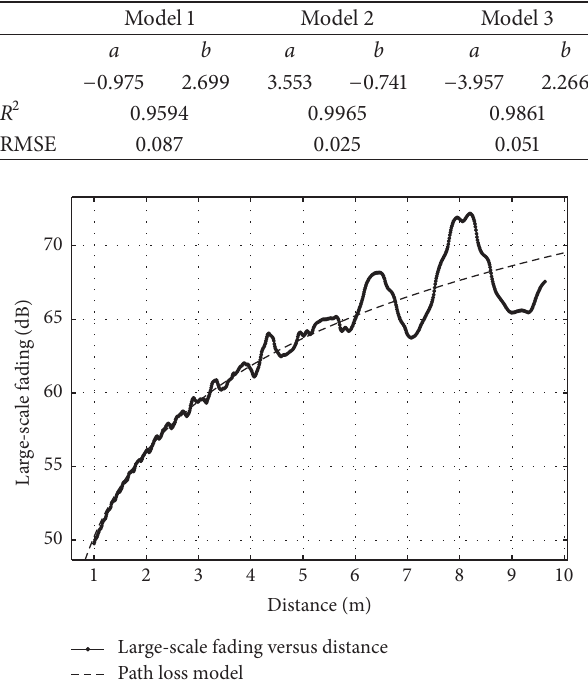
Figure 13: LS fit of large-scale fading versus link distance for a typical